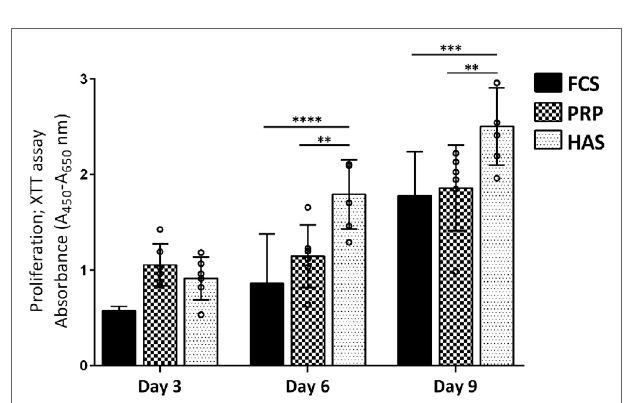
FigUre 2 | Effect of platelet-rich plasma (PRP) or hyperacute serum (HAS) from six individual blood donors on the proliferation of OA chondrocytes (OAC) from three donors. 10% HAS stimulated a higher response from all three donors of OAC on day 6, 9 compared with 10% FCS or PRP. Statistically significant is denoted by ** p < 0.001 and **** p < 0.0001; n = 3 biological replicates.